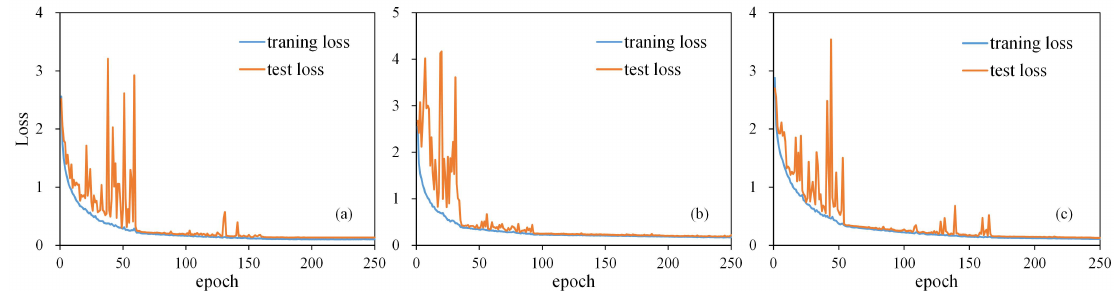
Figure 10. Convergence curves during the fine-tuning process of the Houston 2013 scene: ( a ) SG-CNN-7, ( b ) SG-CNN-8, and ( c ) SG-CNN-12. Table 6. Classification accuracy (%) and computation time of the Houston 2013 scene. A total of 1500 labeled samples (100 per class) were used for fine-tuning. The No. column refers to the corresponding class in Table 5. The best results are in bold